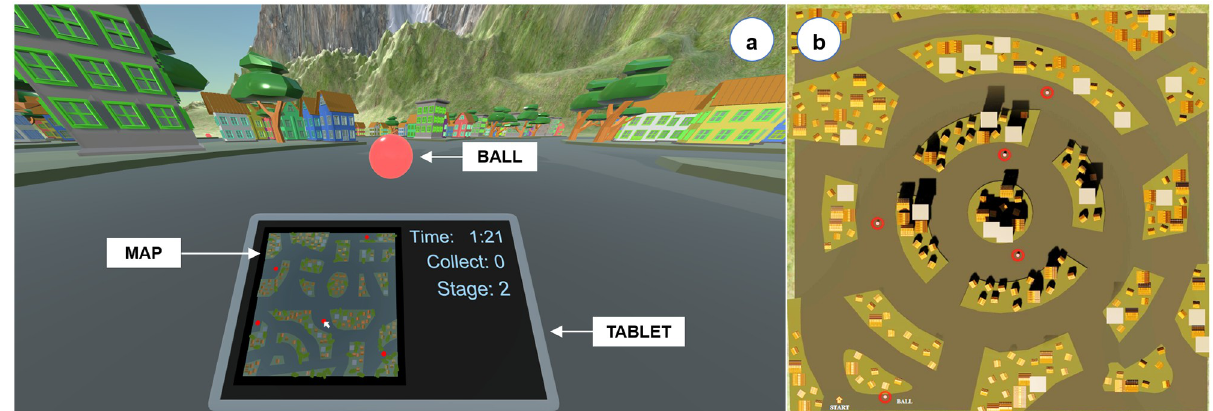
Fig 3. (a) A screenshot of the city navigation scenario from Experiment 1. Participants collected five red balls while navigating through the city using a real-time map displayed on a virtual tablet. (b) An overview of one of the cities from a bird’s eye perspective.